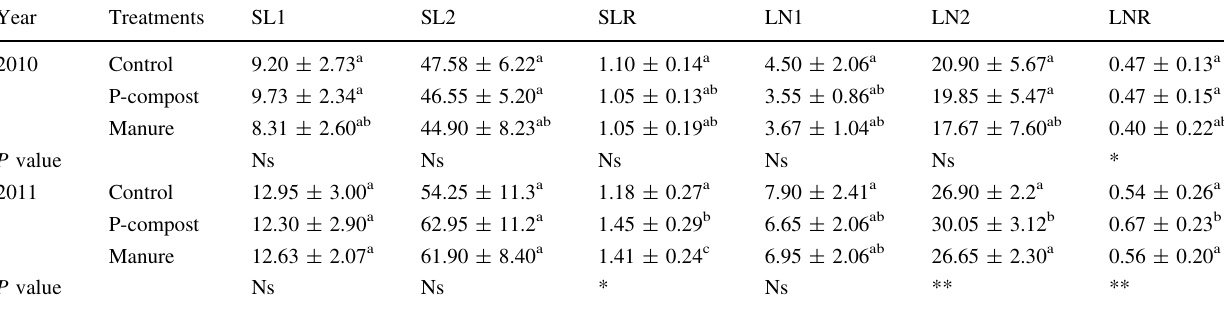
Table 3 Effect of P-compost and cow manure on growth rate of